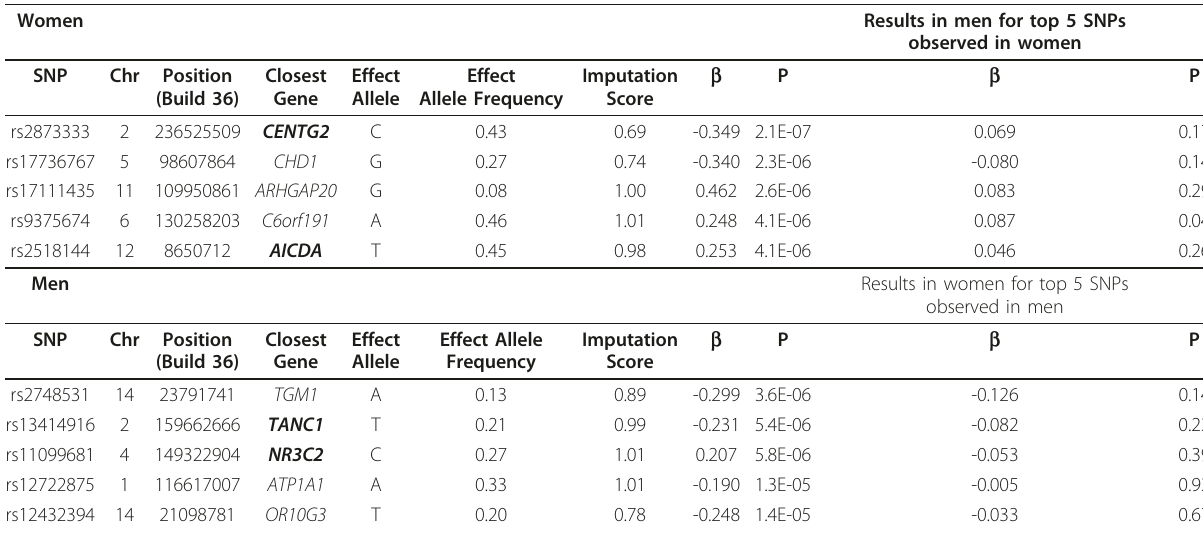
Table 4 Top 5 independent* SNPs associated with renal sinus fat in women (above) and men (below) Women Results in men for top 5 SNPs